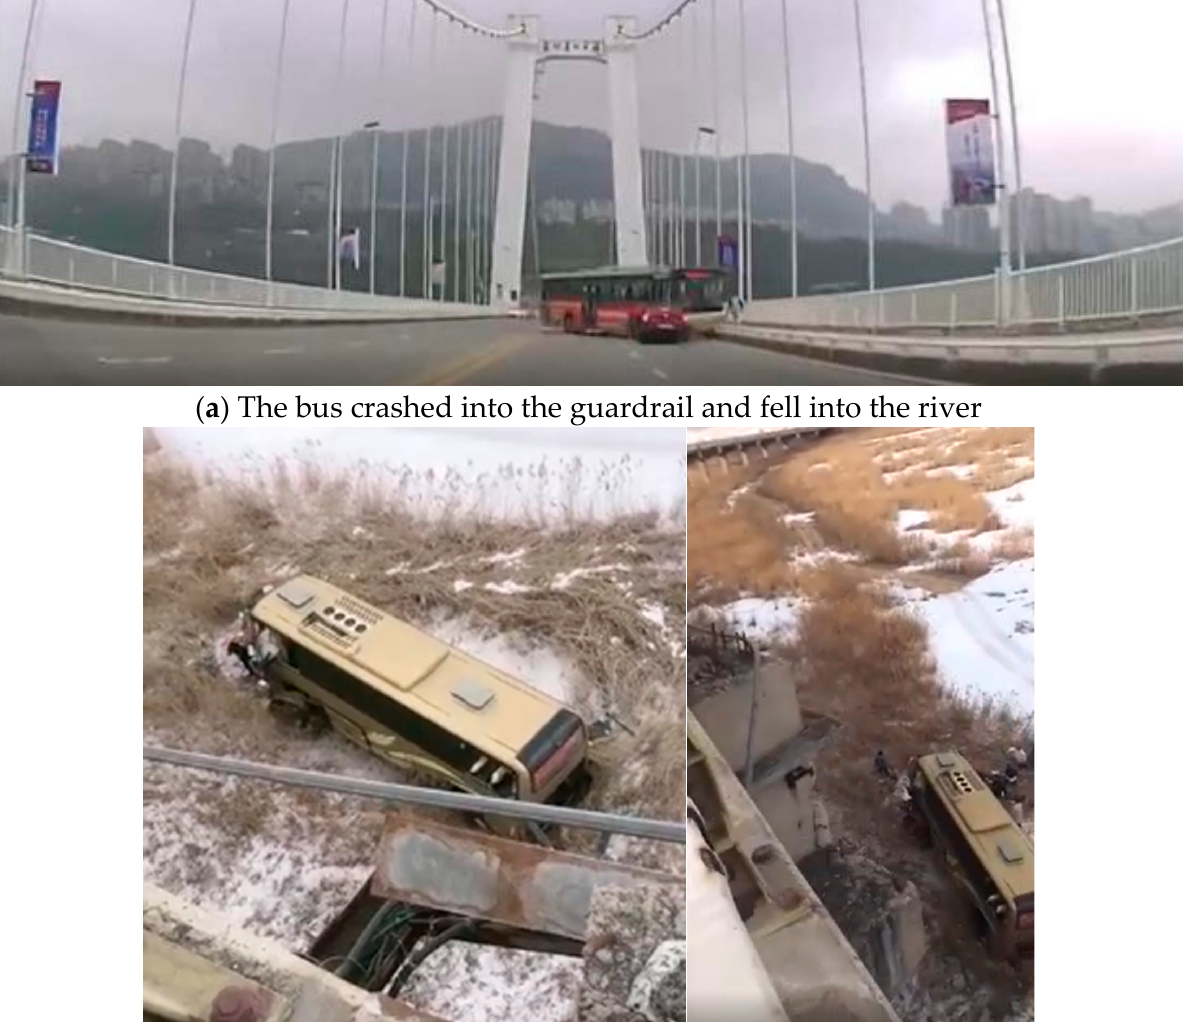
Figure 1. Vehicle collision with a guardrail of a bridge.